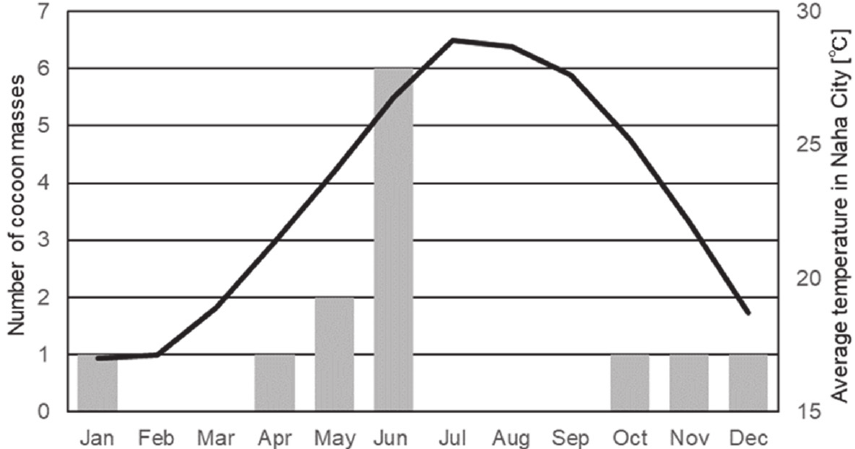
Figure 5. Seasonal changes in the adult emergence of Meteorus stellatus sp. nov. (bars indicating the number of cocoon masses) and in the monthly average temperature in Naha City, Okinawa-hontô Island (a solid